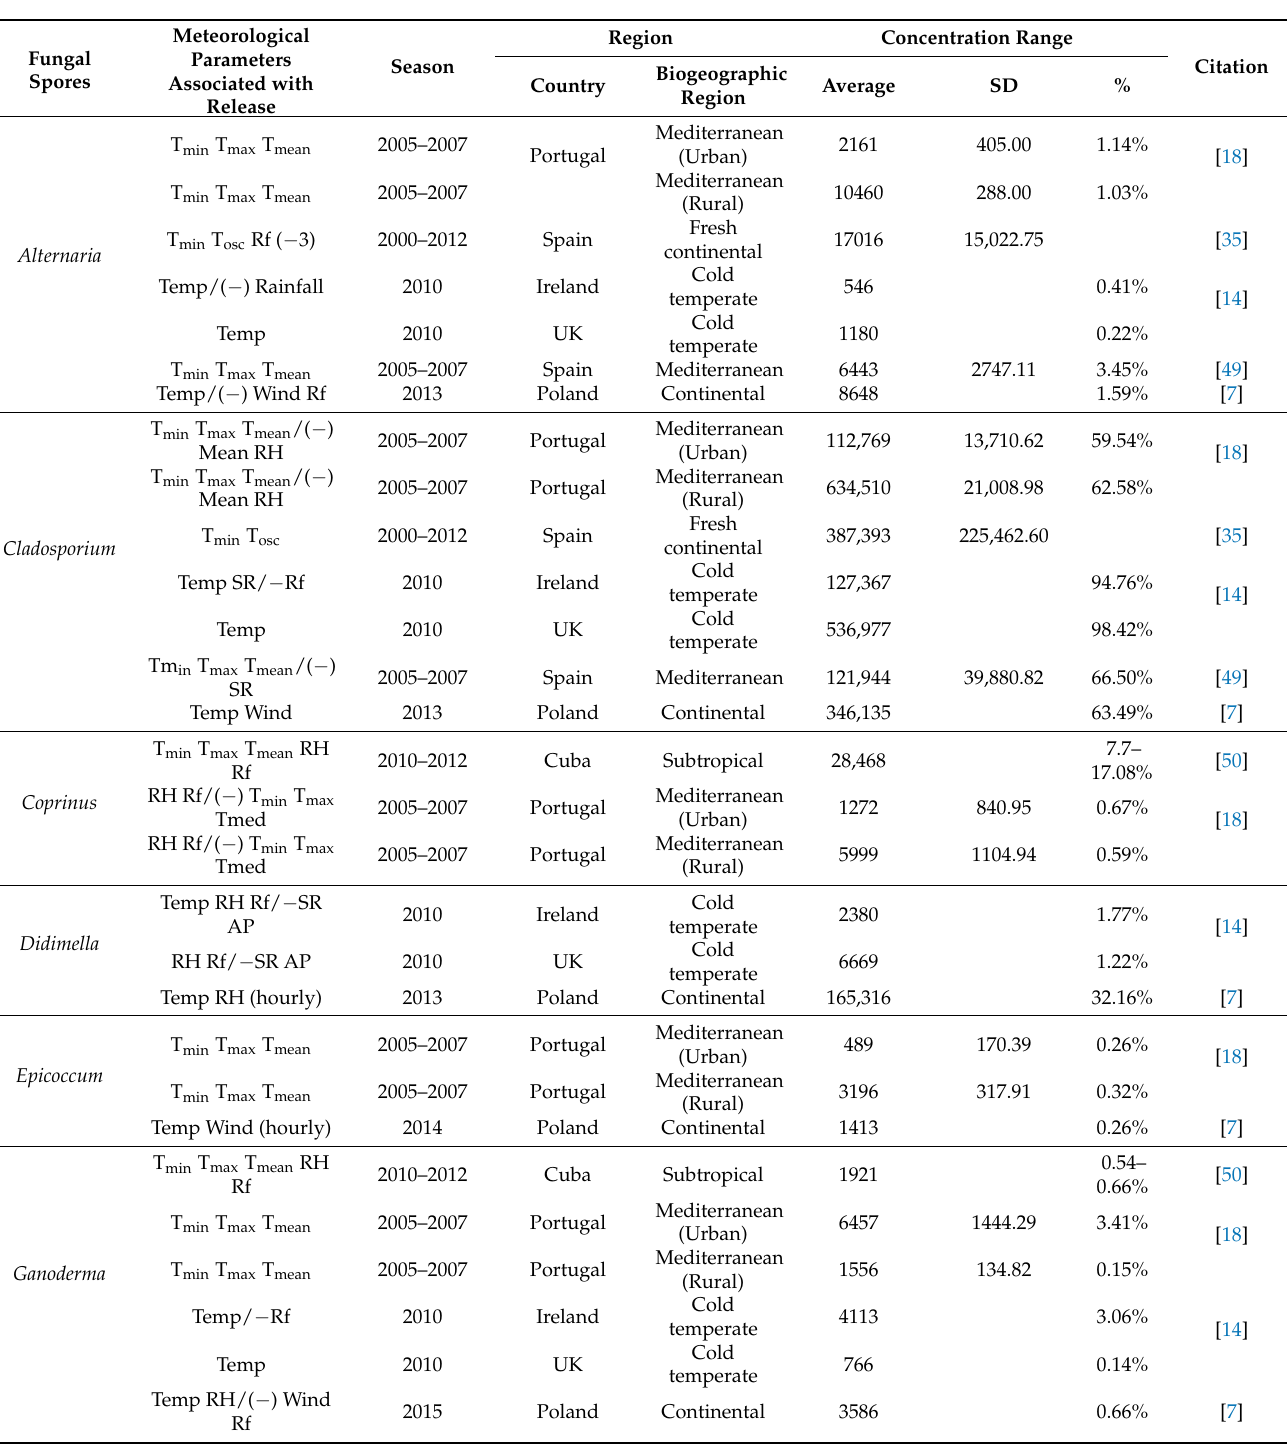
Table 1. Parameters correlated with fungal spores by study region. Temp: Air temperature, T min : minimum temperature, T mean : Average temperature, T max : maximum temperature, T osc : Oscillation of temperature, RH: Relative Humidity, Rf: Rainfall, Rf( − 3): rainfall of 3 days before, AP: air pressure, Wind: wind velocity, SR: Solar radiation, ( − ) negative correlations, (hourly): parameters compared via hourly data, %: percentage of the spore over the total amount of spores in the